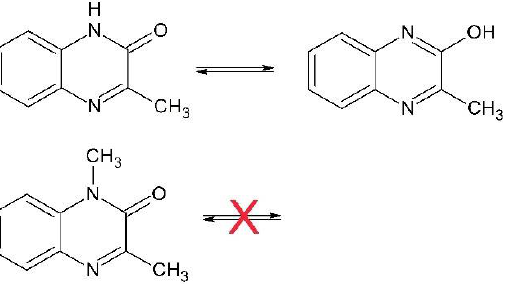
Figure 11. Tautomeric equilibrium of 3-MeQ and the structure of 1,3-dimethylquinoxalin-2-one (1,3-diMeQ).